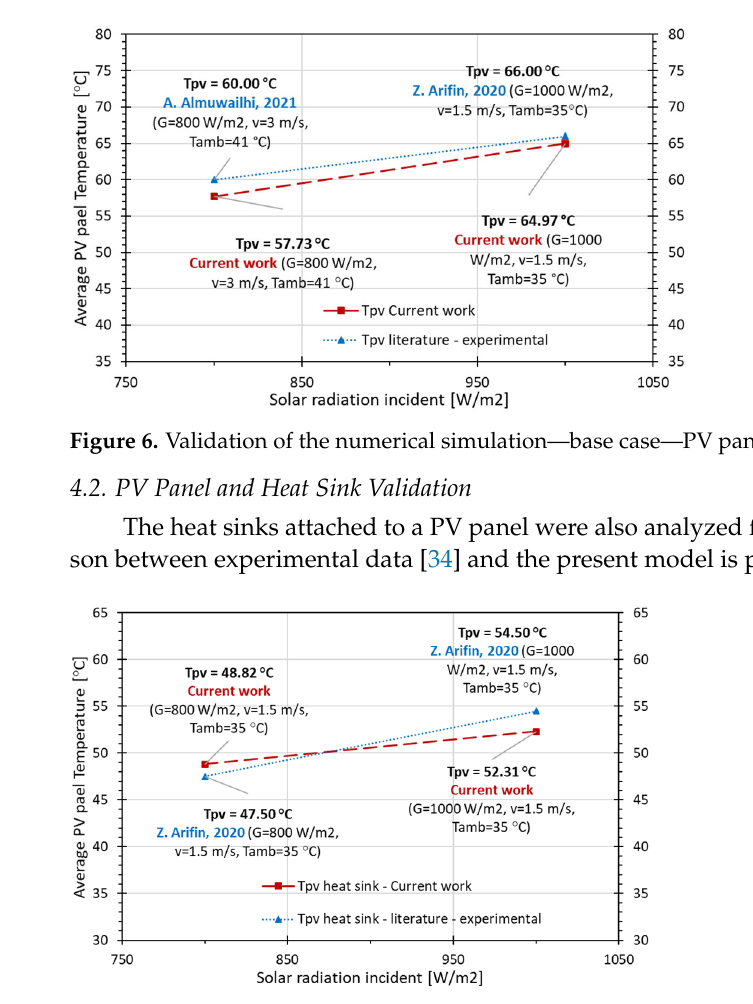
Figure 7. Validation of the numerical simulation—PV panel with heat sink.